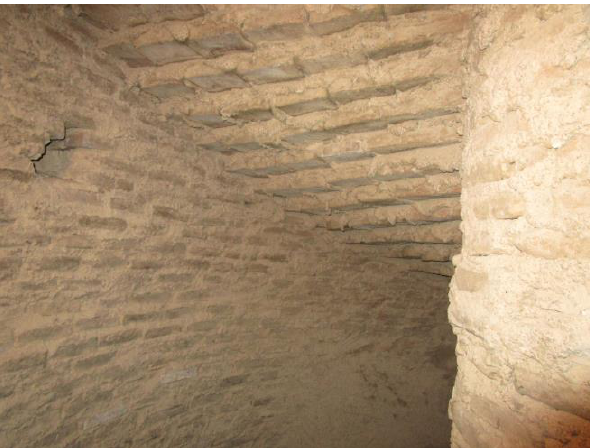
Figure 13. Point at which the central abutment becomes circular and a corbel vault in the spiral